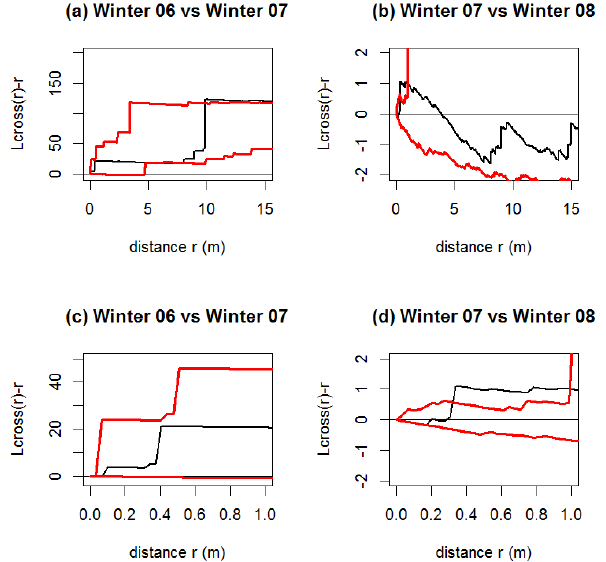
Figure 10. Cross-type L functions computed between subsequent epochs of measurement in winter (black-coloured lines) consider- ing the large erosion scars. (c) and (d) respectively correspond to a zoom on the distance range from 0 to 1m of (a) and (b) . The limits of significance envelope at level of 2% associated to the “popula- tion independence” hypothesis are depicted by red